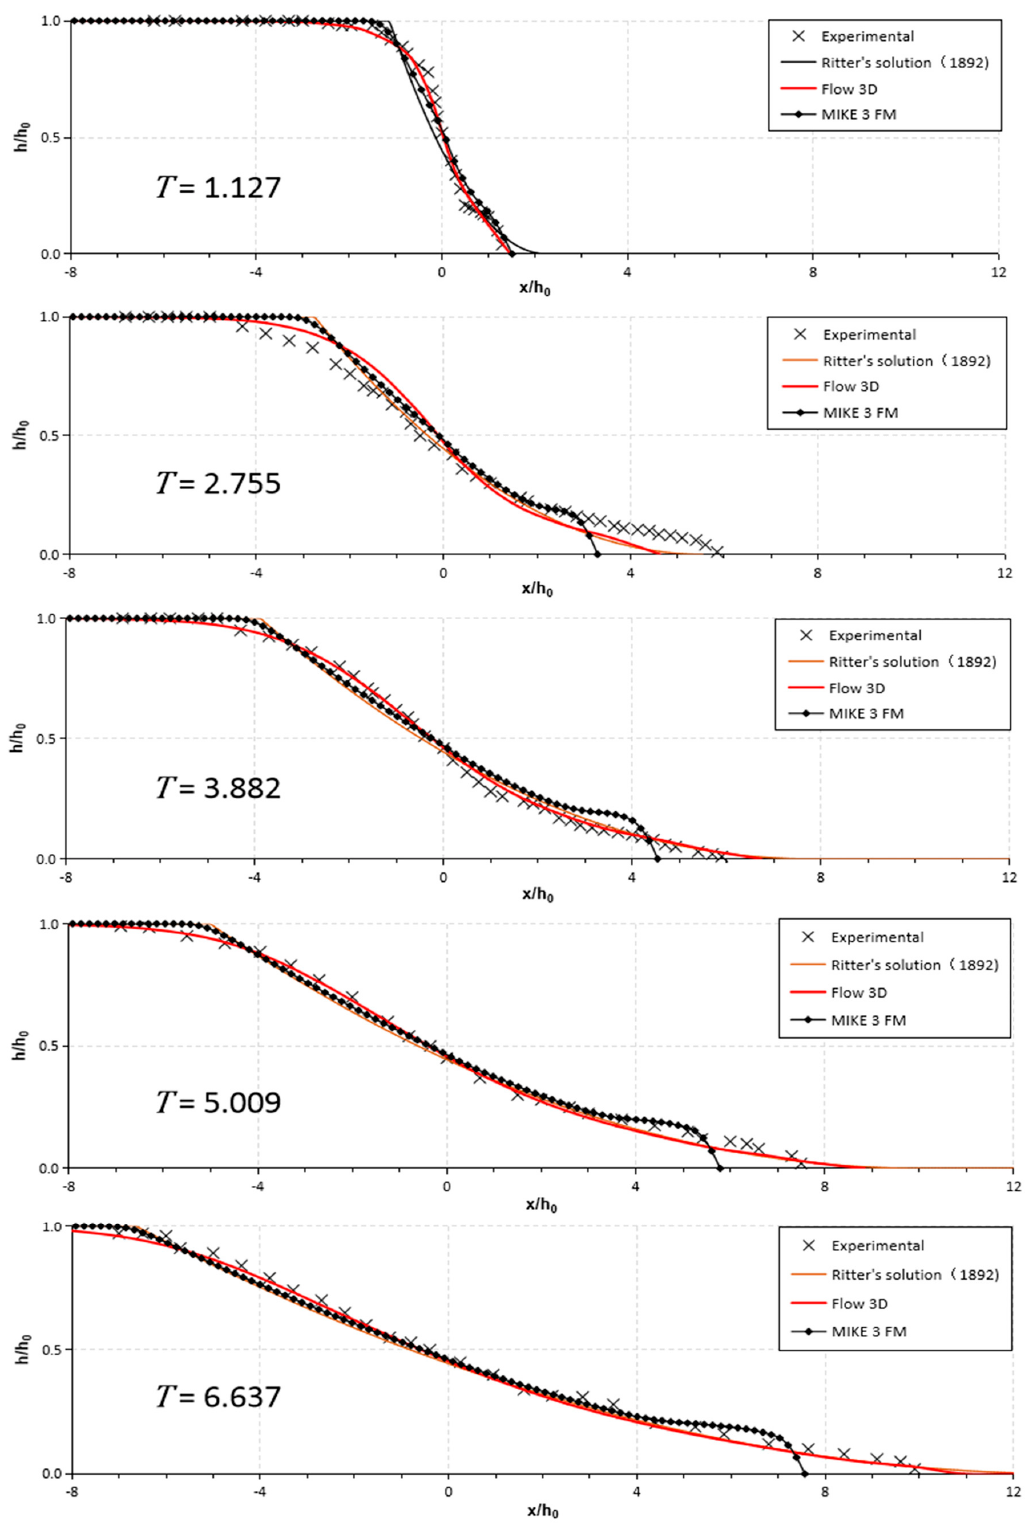
Figure 6. Comparison between observed and simulated free surface profiles at dimensionless times T = t ( g / h 0 ) 1/2 and for dry-bed ( α = 0). The experimental data are from Reference [30].